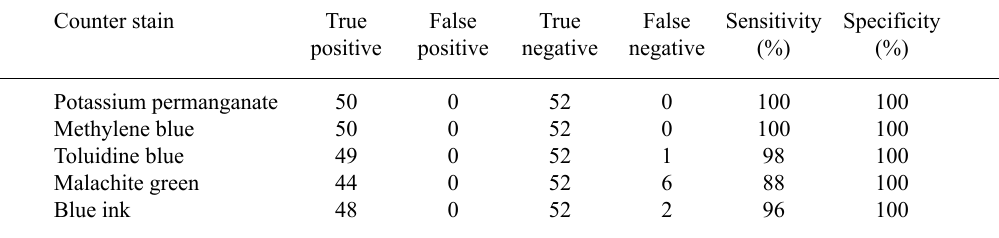
Table 2. Sensitivity and specificity of five different counter stains